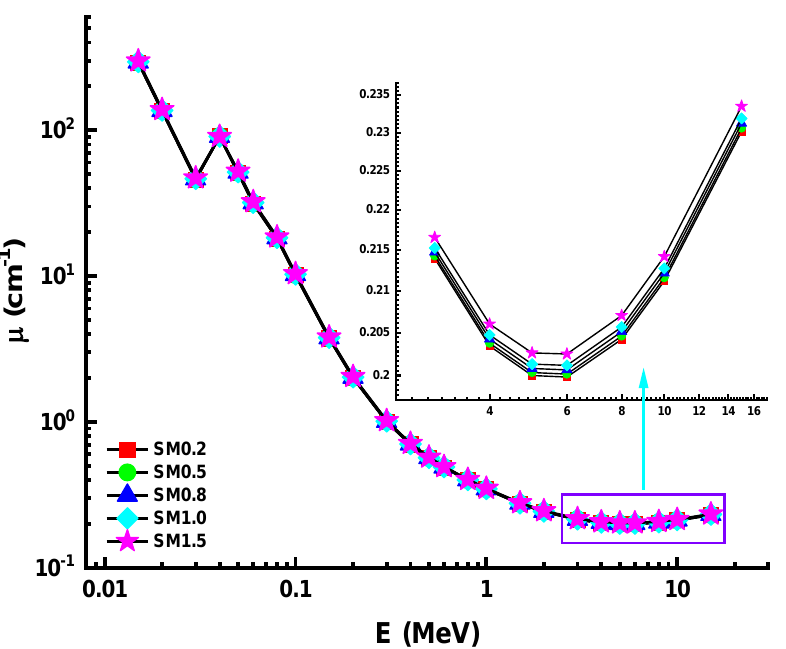
Figure 4. Variation of linear attenuation coefficient (µ) against Photon energy for all glasses.